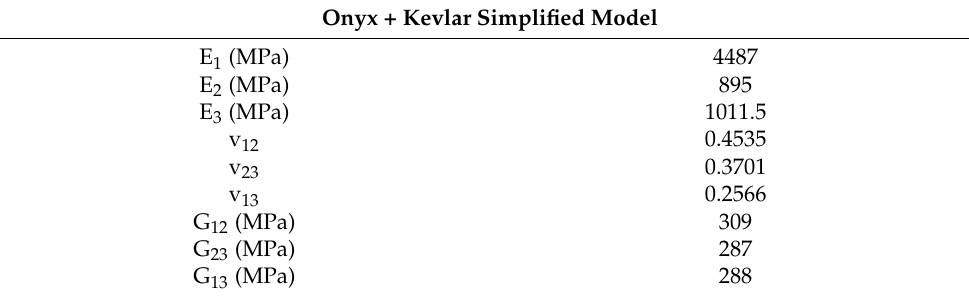
Table 4. Mechanical properties used for the fatigue